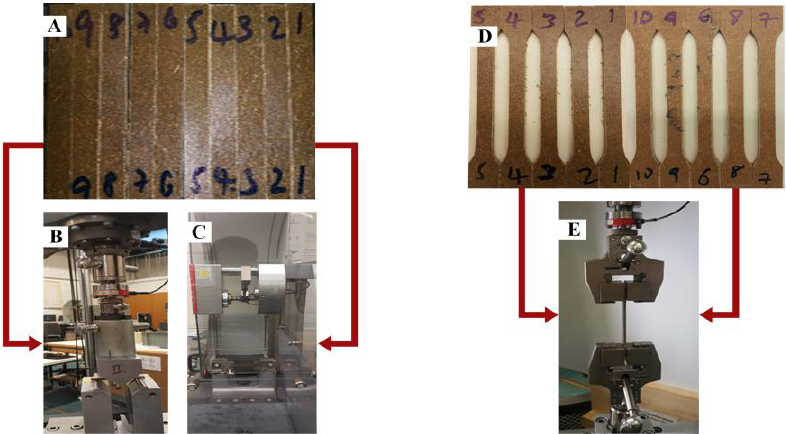
Figure 4. ( A ) Samples for both FS and UIS; ( B ) FS test; ( C ) UIS test; ( D ) TS sample; ( E ) TS test.